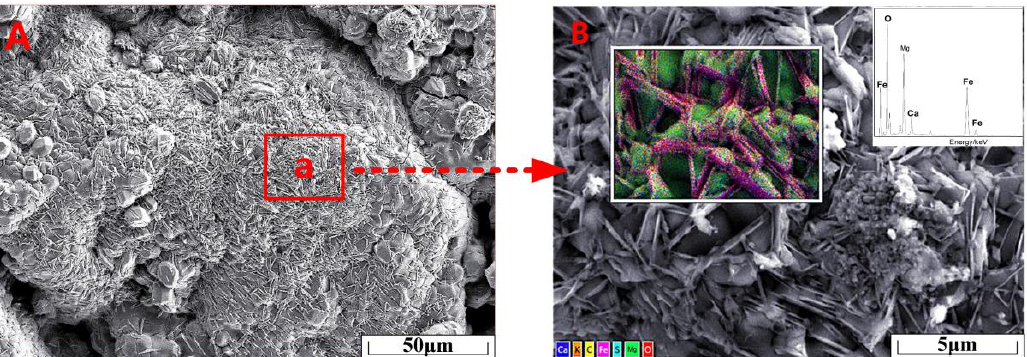
Figure 9. SEM and EDS analysis of nickel slag samples after oxidation at 900 °C for 30 min. ( A ) SEM image of nickel slag samples; ( B ) energy-dispersive spectrum of region a.